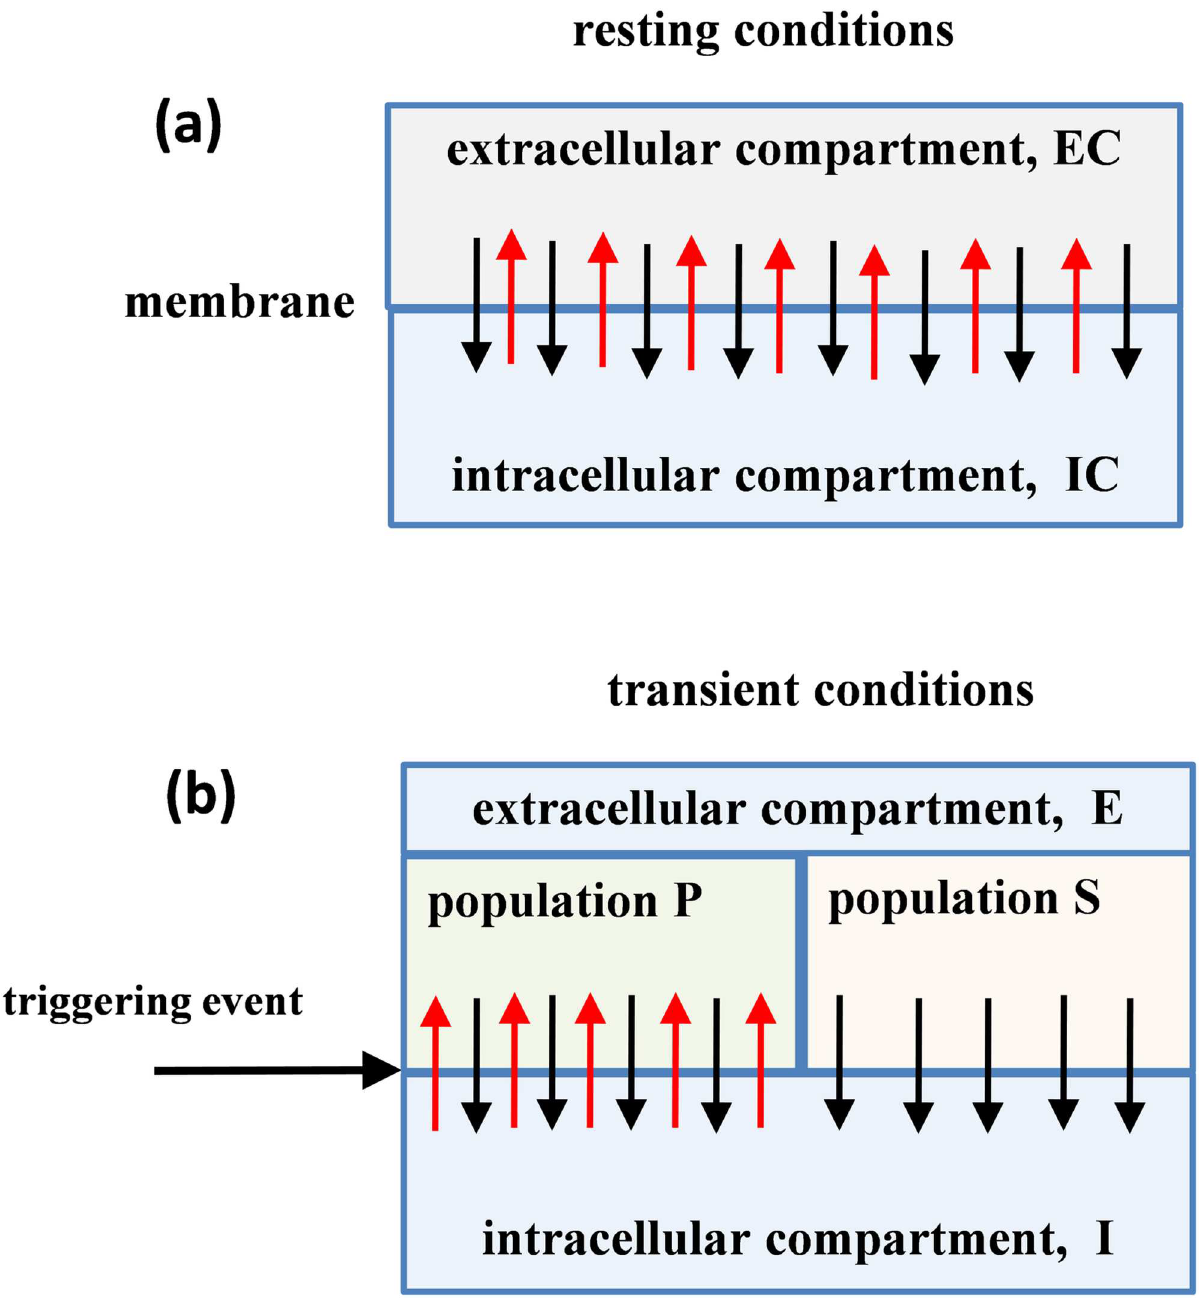
Fig 6. Block scheme of particle exchange between intra-cellular and extra-cellular ion compartments divided by a membrane. The black and red arrows show directions of the membrane crossings by ions of opposite polarity. (a) Resting conditions with balanced transmembrane ion transport. (b) Formation of primary (P) and secondary (S) extracellular particle populations during transient